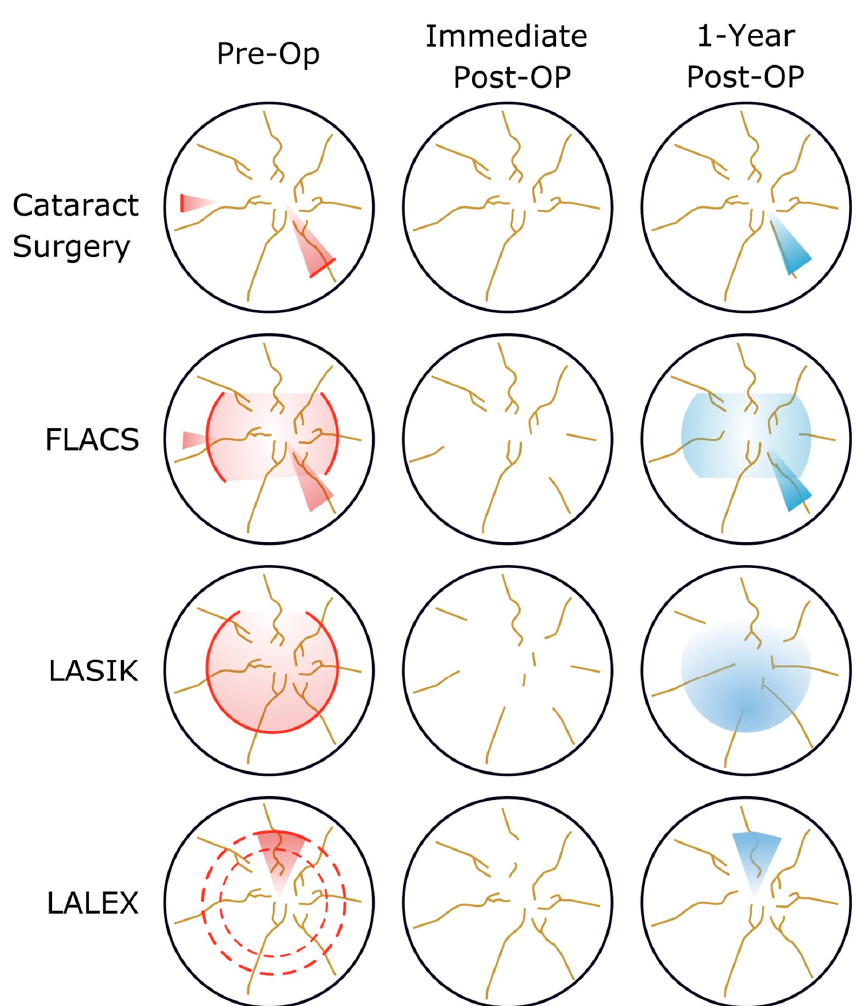
Figure 1. Neurotrophic Etiologies for Surgical Temporary Ocular Discomfort Syndrome (STODS) with a variety of corneal surgical interventions. Transection of nerve occurs in a varying amount with the variety of corneal surgeries as compared to cataract surgery without femtosecond arcs. When femtosecond arcs are employed, the potential for greater nerve transection and thus STODS develops. Similarly, LASIK transects more corneal nerves than LASIK; therefore one would expect greater STODS in the former surgery. Fortunately, by one year, all corneal surgeries are followed by robust nerve regrowth to nearly baseline levels.